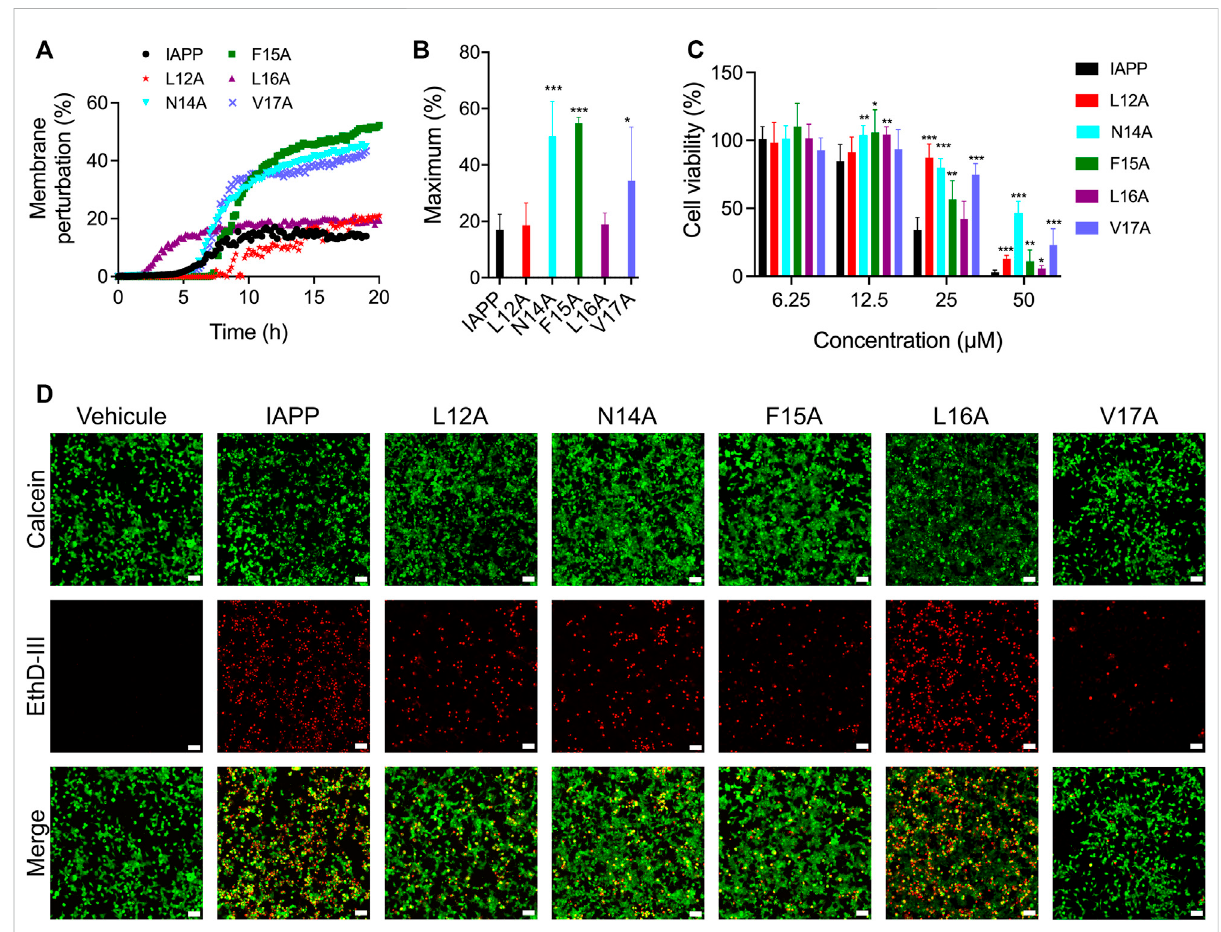
FIGURE 5 Lipid vesicle perturbation and cytotoxicity of Ala-substituted IAPP derivatives. (A) Kinetics of lipid membrane perturbation. 500 μ M of calcein- loaded LUVs (DOPC:DOPG; 9:1) were exposed to 25 μ M peptide in 20 mM Tris-HCl, 150 mM NaCl, pH 7.4, and fl uorescence was measured every 10 min. (B) Maximumlipidmembraneperturbationofatleastfourassaysperformedwithdifferentpeptidelots.Dataareexpressedasthemean±S.D. (C) INS-1Ecellsweretreatedwithfreshlydissolvedpeptidesfor24 handmetabolicactivitywasmeasuredbymeansofresazurinreduction.Data of at least fi ve assays were averaged and expressed as themean ± S.D. (D) Representative fl uorescence microscopy imagesshowing the distribution of live (green) and dead (red) INS-1E cells after treatment with 25 μ M peptides for 24 h. Scale bar: 50 μ m. (B,C) Statistically signi fi cant difference (between IAPP and analogs) was established at (*) p < 0.05; (**) p < 0.005; (***) p <